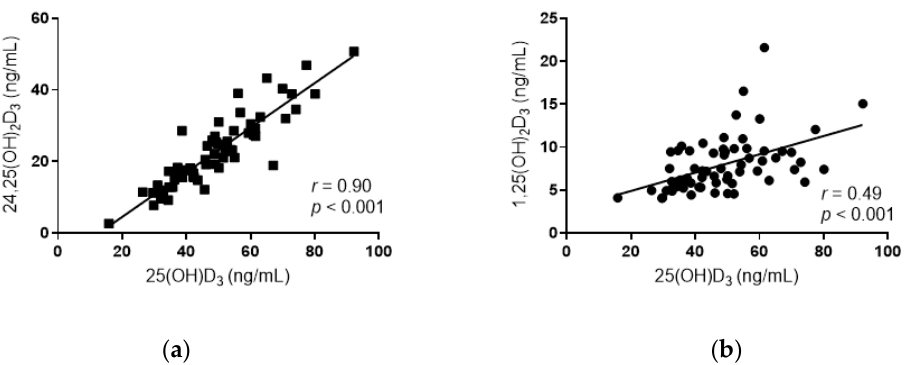
Figure 1. Relationship between the concentrations of 24R ,25-dihydroxyvitamin D 3 (24,25(OH) 2 D 3 ) ( a ) and 1 α ,25-dihydroxyvitamin D 3 (1,25(OH) 2 D 3 ) ( b ) with 25-hydroxyvitamin D 3 in all subjects ( n = 65). Pearson correlation coefficients ( r ) and p -values are shown.